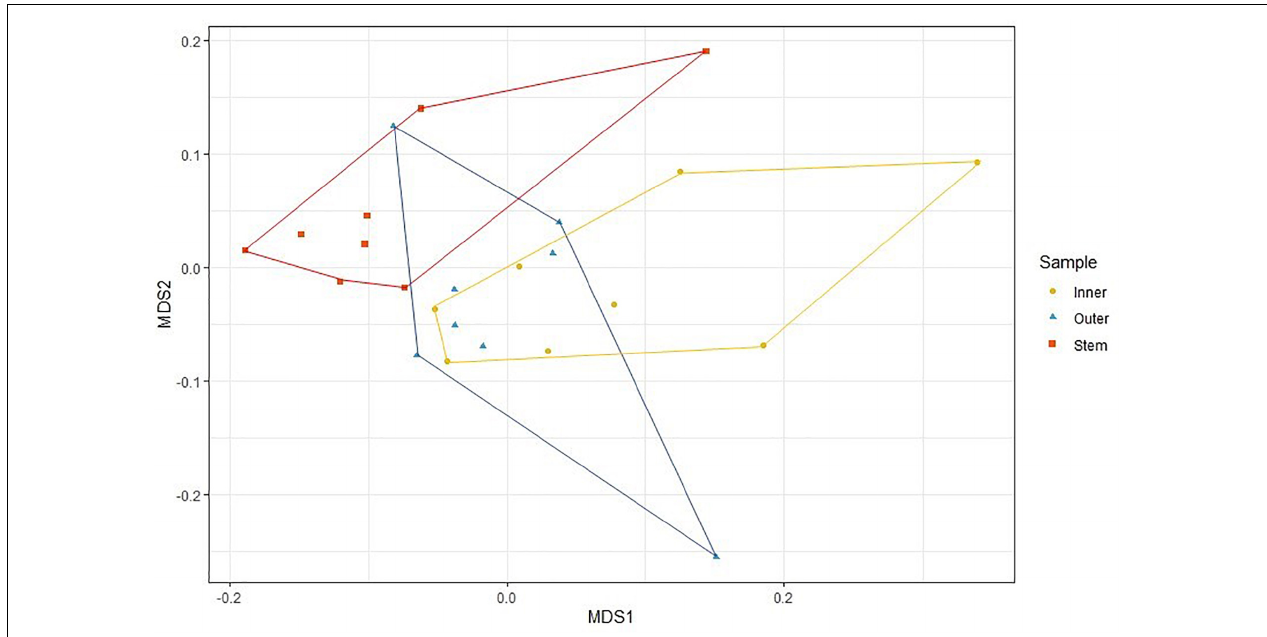
FIGURE 2 | nMDS plot of prokaryotic community structure in the Inner cup, Outer cup, and Stem of Cliona patera .